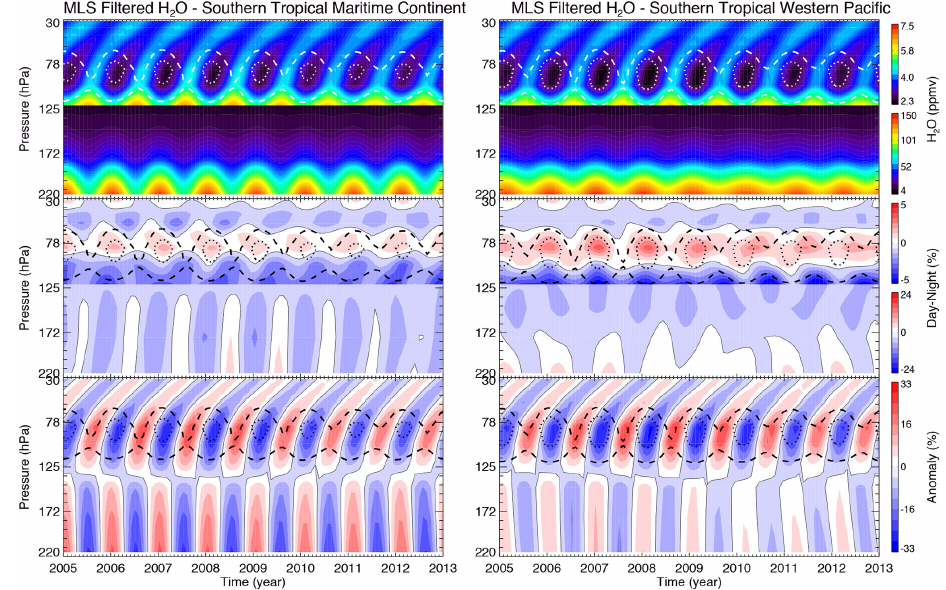
Figure 6b. Same as Fig. 6a but for the southern tropical maritime continent (left) and the southern tropical western Pacific (right).